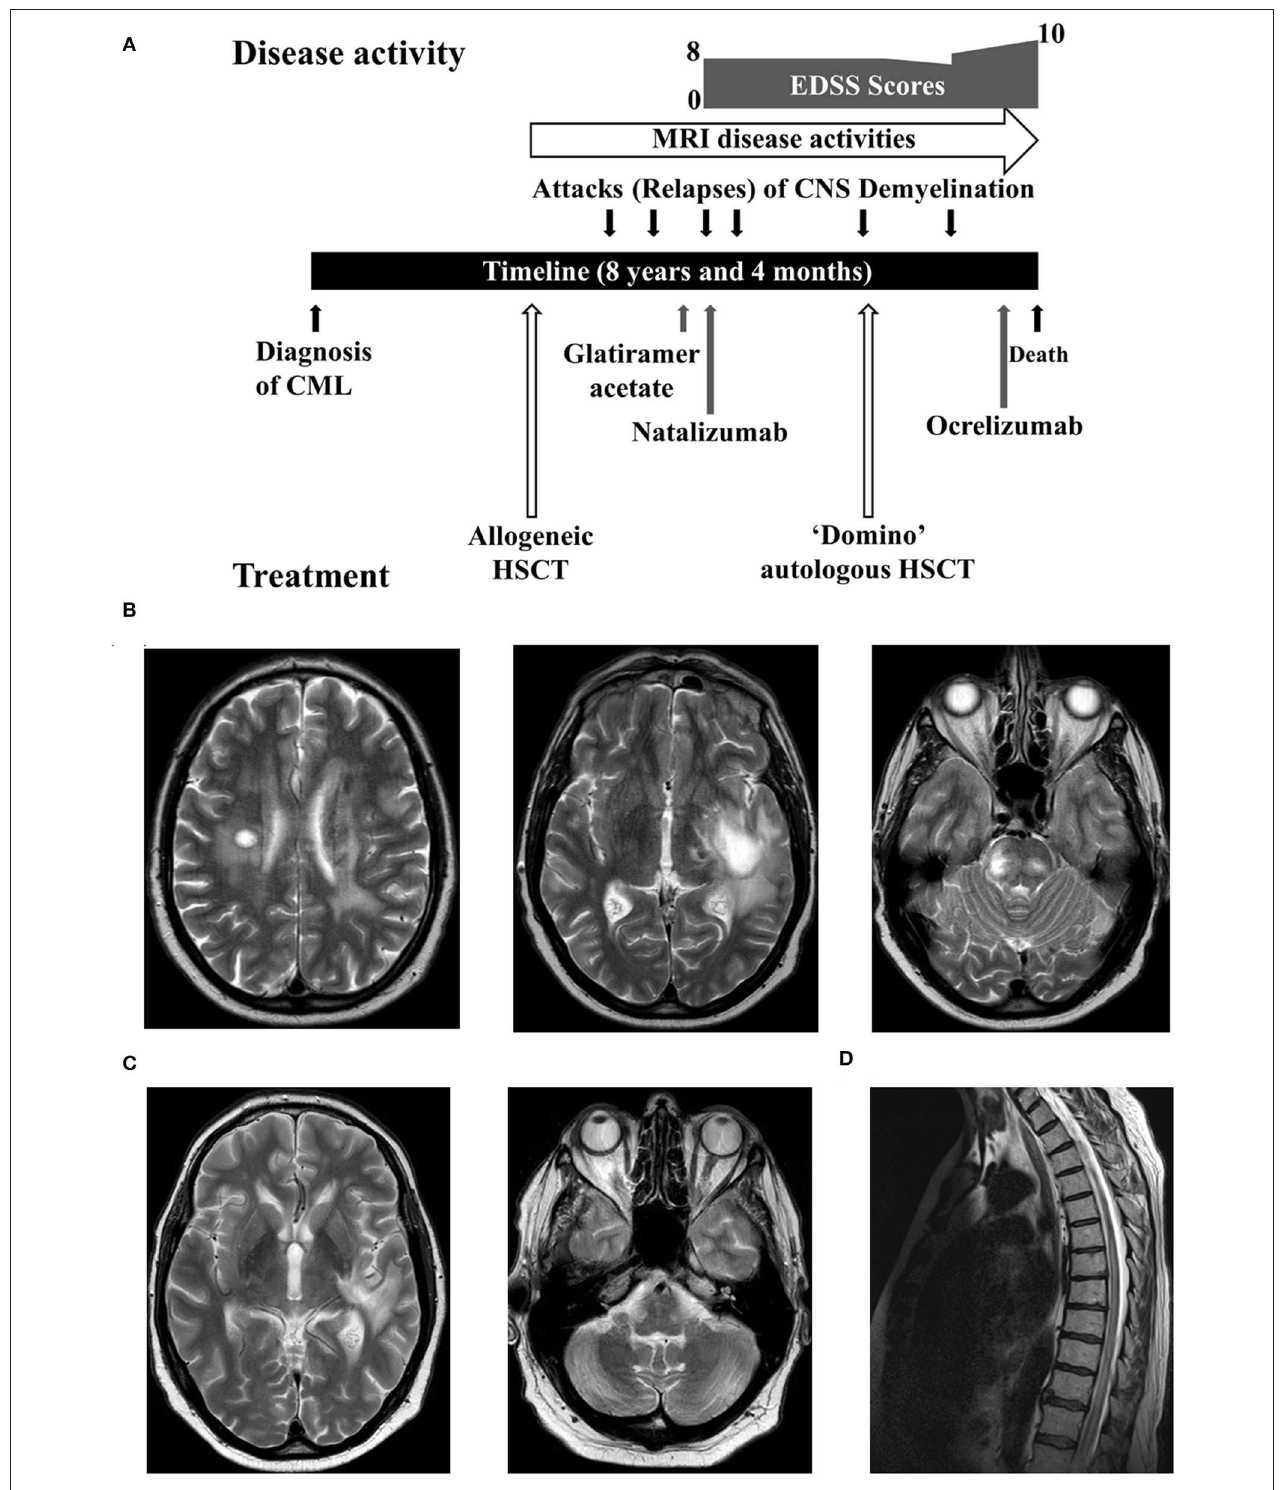
FIGURE 1 | (A) A summary of the disease course. (B) Axial sections of the brain MRI showed tumefactive lesions. (C) Improvement of the edema around tumefactive lesions. (D) The spine MRI demonstrated a lesion extending from the thoracic cord to conus.